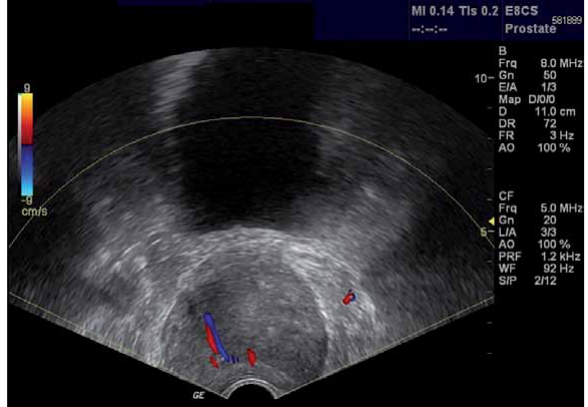
Figure 2 - PDUS examination of the prostatic vasculature showing urethral